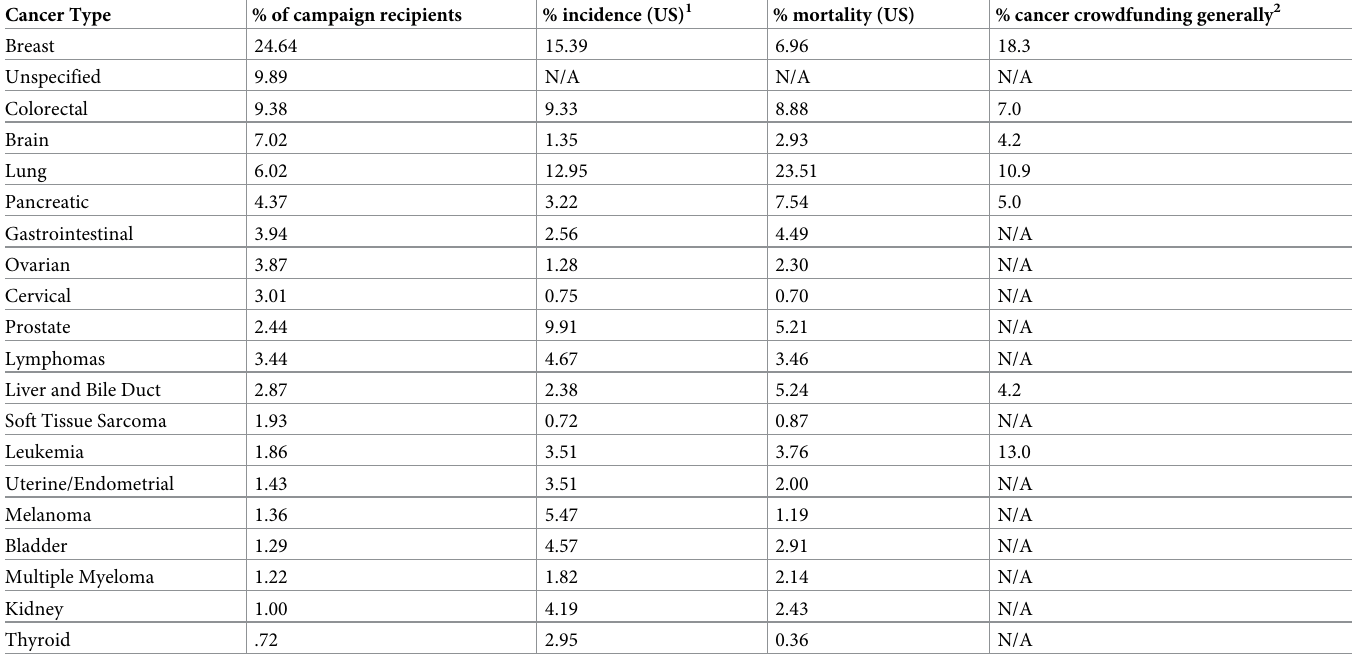
Table 4. Cancer types by incidence and mortality. Cancer